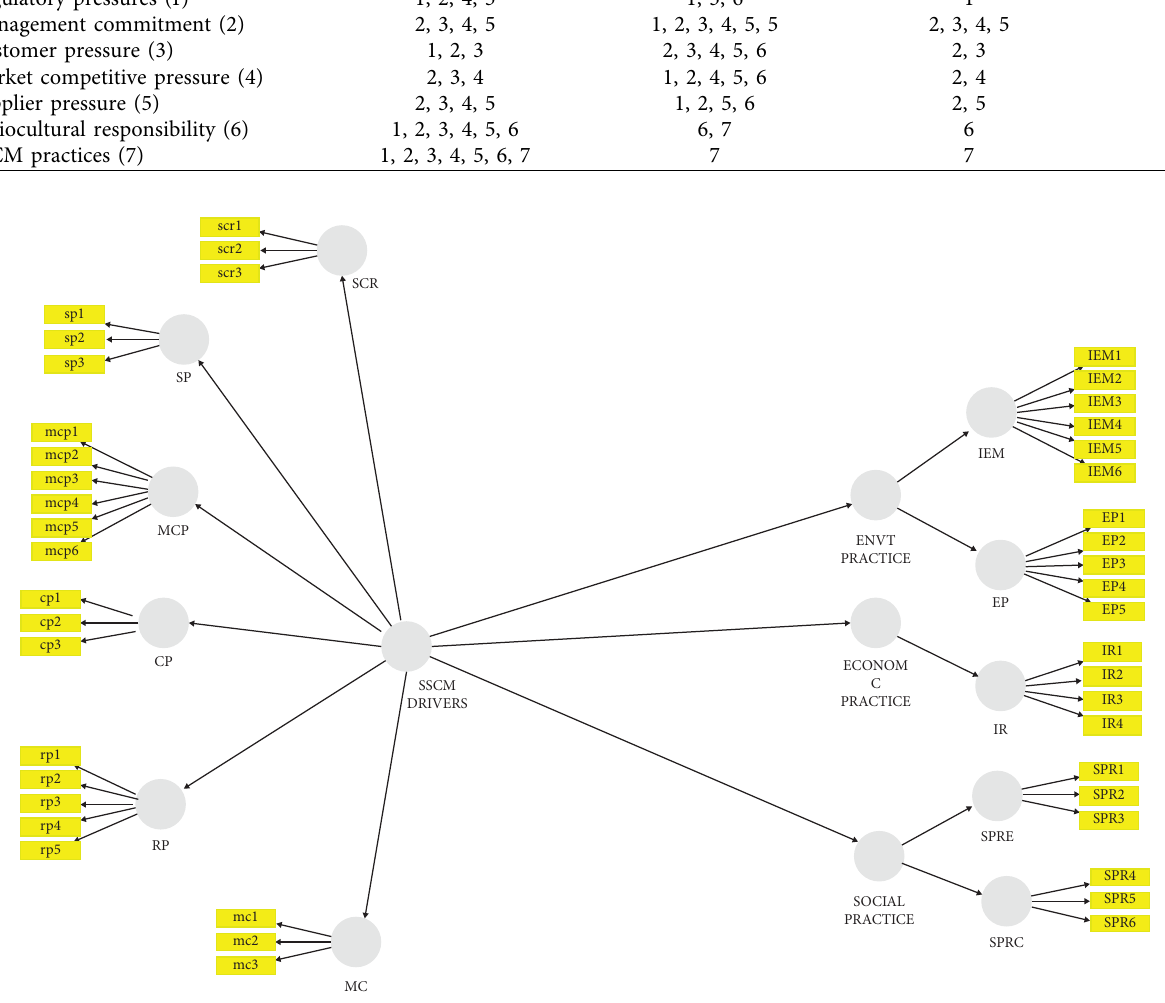
Figure 2: Structural